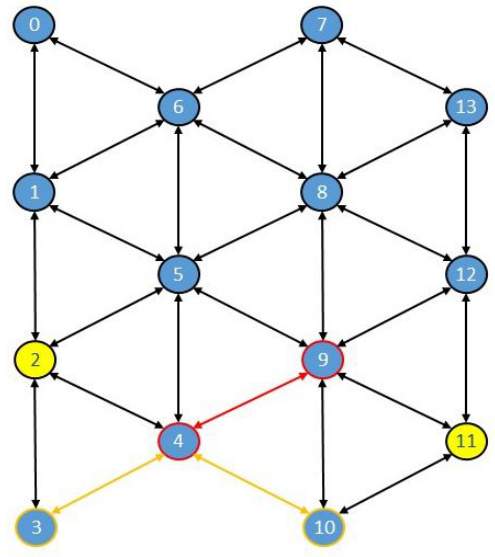
Figure 9. Configuration of the